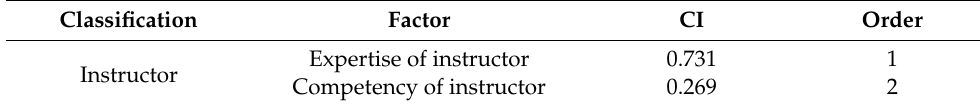
Table 4. Results of the relative importance of the instructor in H3. Classification Factor CI Order Expertise of instructor 0.731 1 Instructor Competency of instructor 0.269 2